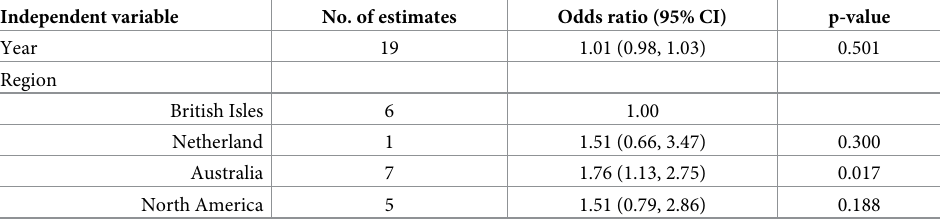
Table 4. Meta-regression of 12-month prevalence estimates of antibiotic use in long-term care facilities (N = 19).